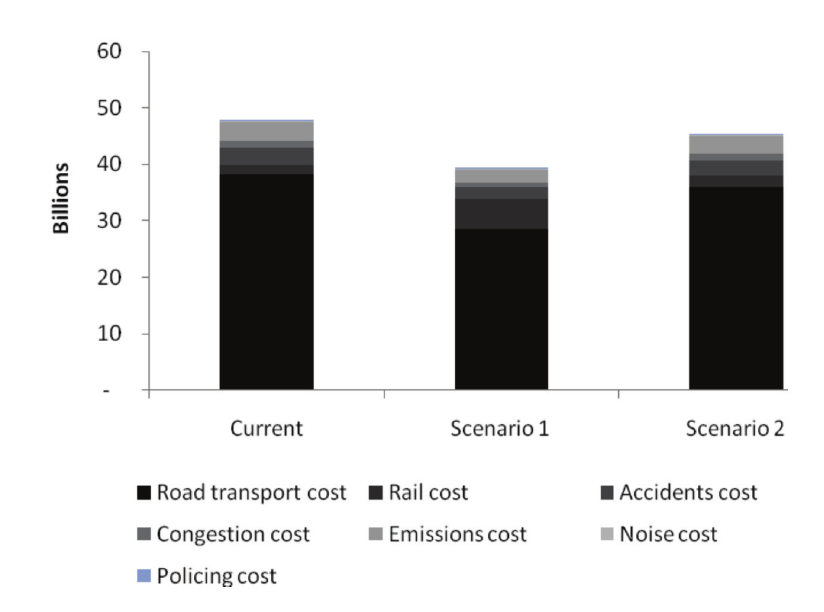
Figure 7: Future comparative cost components: current vs. switching scenarios (data source: FDM, 2009, and CSCM Cost Model,